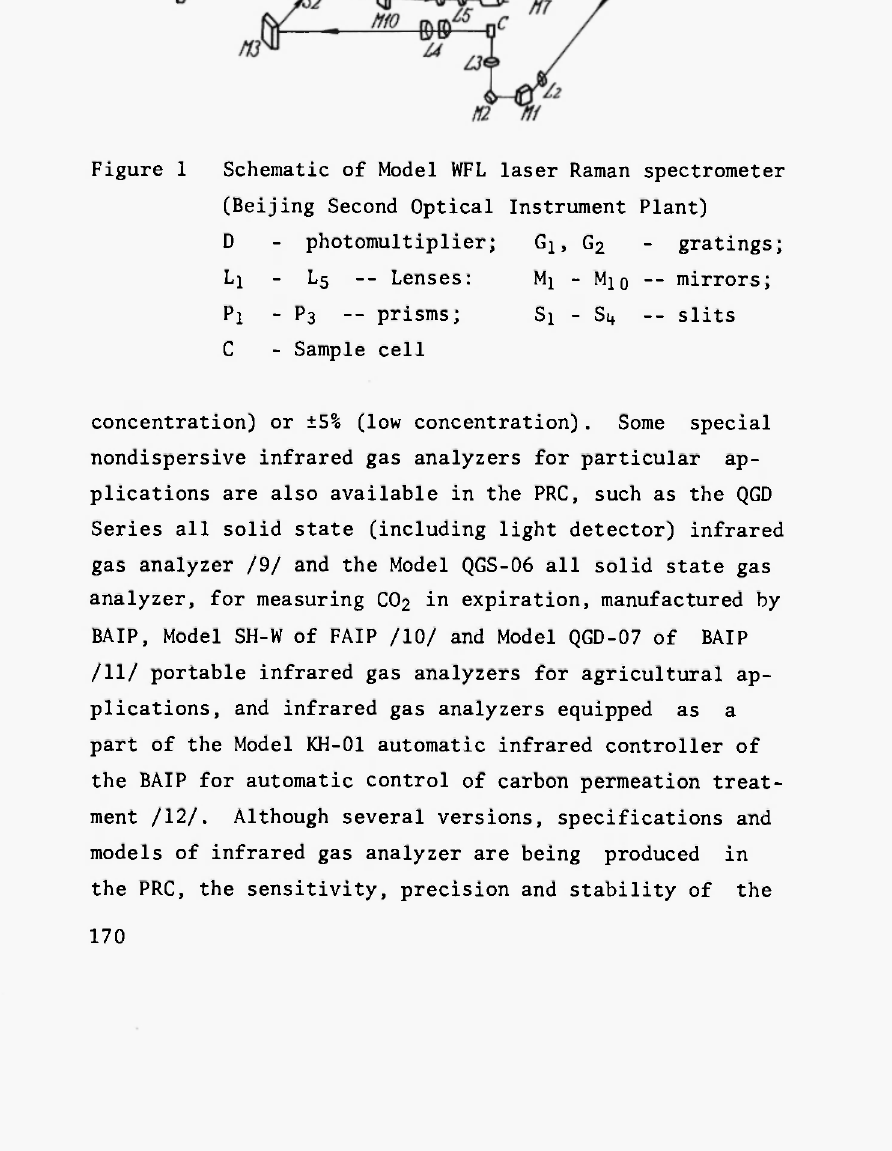
Figure 1 Schematic of Model WFL laser Raman